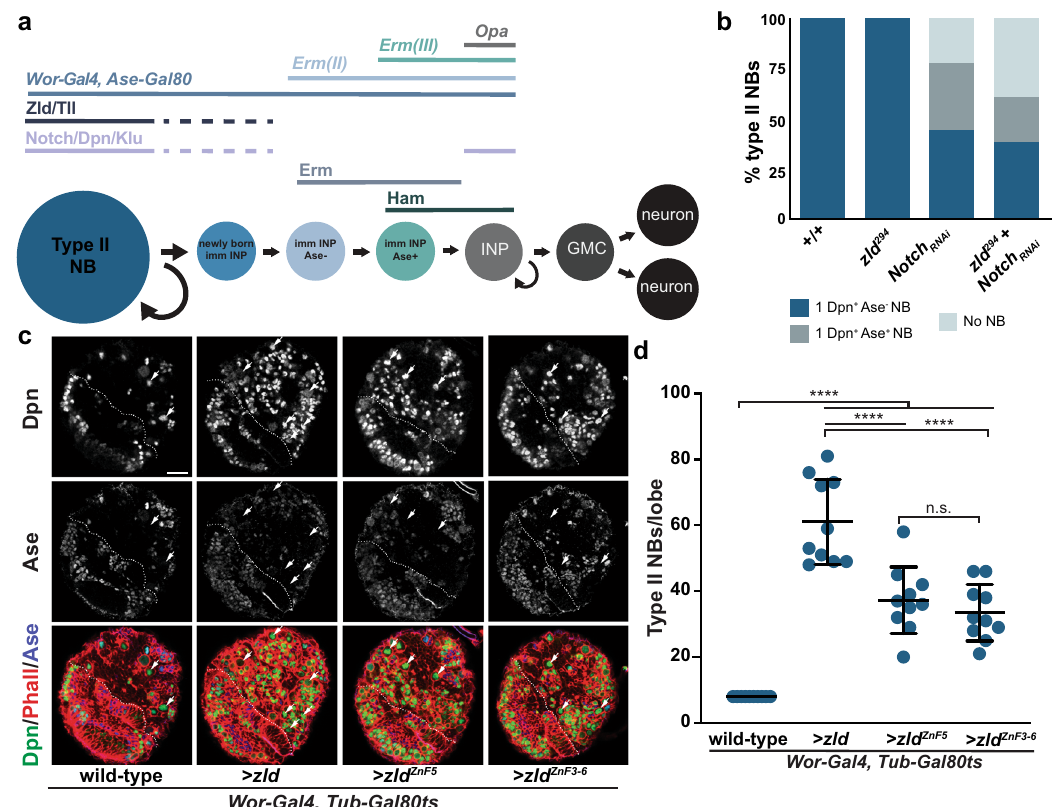
Fig. 1 Zld promotes the undifferentiated type II neuroblast fate. a Expression of self-renewal factors (Notch/Dpn/Klu), Tll, Zld, Erm, and Ham and cell- type speci fi c drivers along the type II neuroblast (NB) lineage. b Percent of clones of the indicated genotype with neuroblasts (NB) expressing Dpn and/or Ase or lacking cells expressing these neuroblast markers. For + / + n = 14 clones, zld 294 n = 16 clones, Notch RNAi n = 9 clones, zld 294 + Notch RNAi n = 13 clones. c Immunostaining of third instar larval brain lobes without transgene expression (wild-type), expression of ectopic Zld (> zld ), expression of Zld with a mutation in the fi fth zinc fi nger (> zld ZnF5 ), and expression of Zld with mutations in zinc fi ngers 3 – 6 (> zld Zn3-6 ) in type I and type II neuroblasts ( Wor-Gal4, Tub-Gal80ts ) at 33 °C. White dashed line highlights the division between the optic lobe and the brain. White arrows indicate a selection of Dpn + , Ase − type II neuroblasts. Scale bar, 20 µ m. d Quanti fi cation of type II neuroblasts per lobe for the genotypes indicated. Wild-type (8 ± 0), > zld (61.1 ± 13), > zld ZnF5 (37.3 ± 10.1), and > zld Zn3-6 (33.5 ± 8.5). Mean number of type II neuroblasts is shown, and error bars show the standard deviation for a sample. For each genotype: n = 10 brains. Comparisons were performed with a one-way ANOVA with post-hoc Tukey ’ s HSD test; n.s. p -value = 0.7952, **** p - value ≤ 0.0001. Source data are provided as a Source Data fi